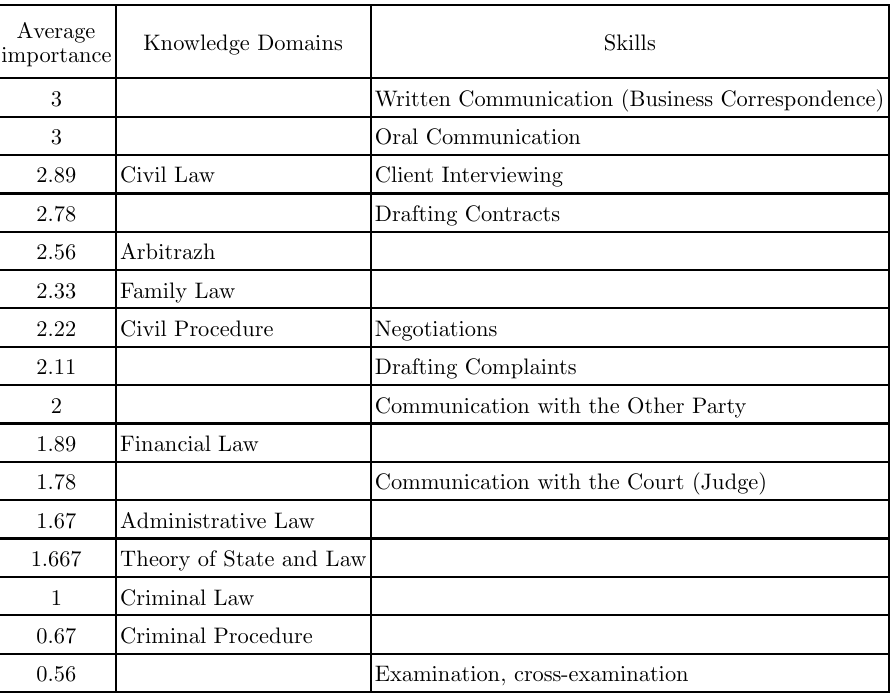
Average importance of knowledge and